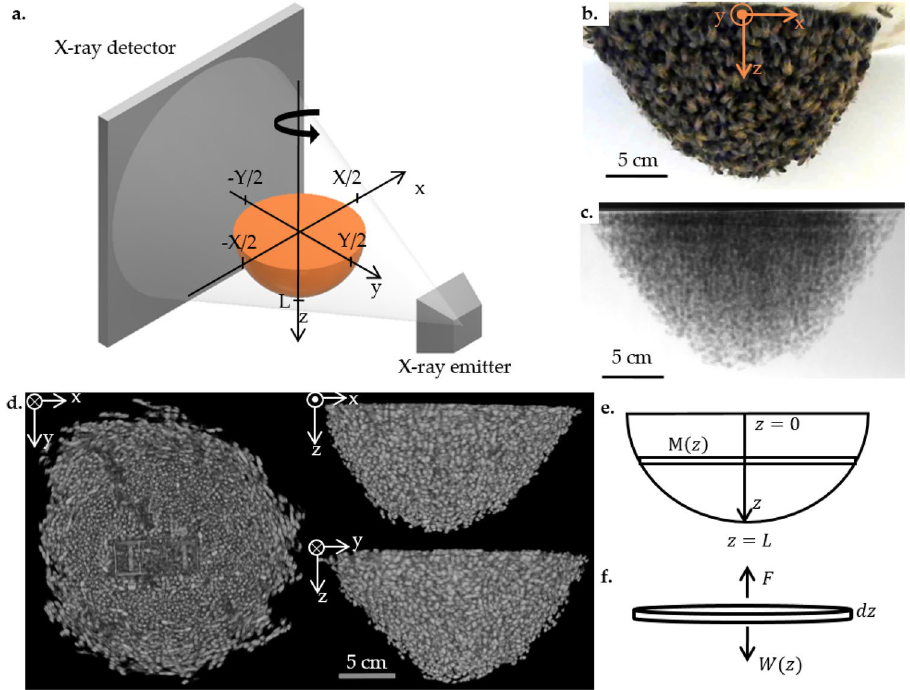
Figure 1. ( a ) Schematic of x-ray CT setup. The swarm hangs from a rotating board between the x-ray emitter and detector. As the swarm rotates about the z-axis, the emitter generates x-rays and the detector saves the resulting projections. ( b ) Photograph of a 753 g swarm taken right before a CT scan. ( c ) Sample projection of the CT scan of the swarm in ( b ). Darker gray pixels represent more bees in the path of the x-ray beam. ( d ) Volume rendering of a reconstruction of the swarm in ( b ), shown from three different orientations: top view, right below the attachment surface (left), front view (top right), and right-side view (bottom right). Brighter voxels represent a higher bee mass, and black voxels represent no bees. See Supplementary video V2 for a video of the rotated reconstruction. ( e ) Schematic of the swarm with a vertical coordinate z . The swarm is made up of layers with mass M ( z ) and thickness dz . ( f ) Free body diagram of a dz thick layer of the swarm. The force each layer of bees exerts to support the swarm, F , is equal to the weight of the layers underneath it, W ( z